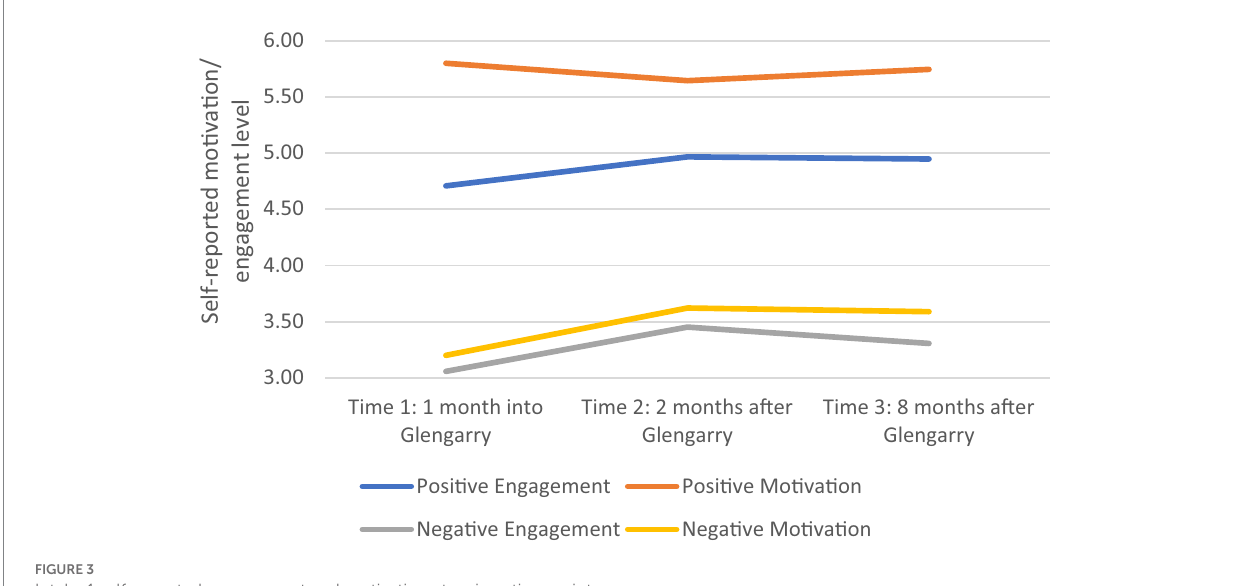
FIGURE 3 Intake 1 self-reported engagement and motivation at various time